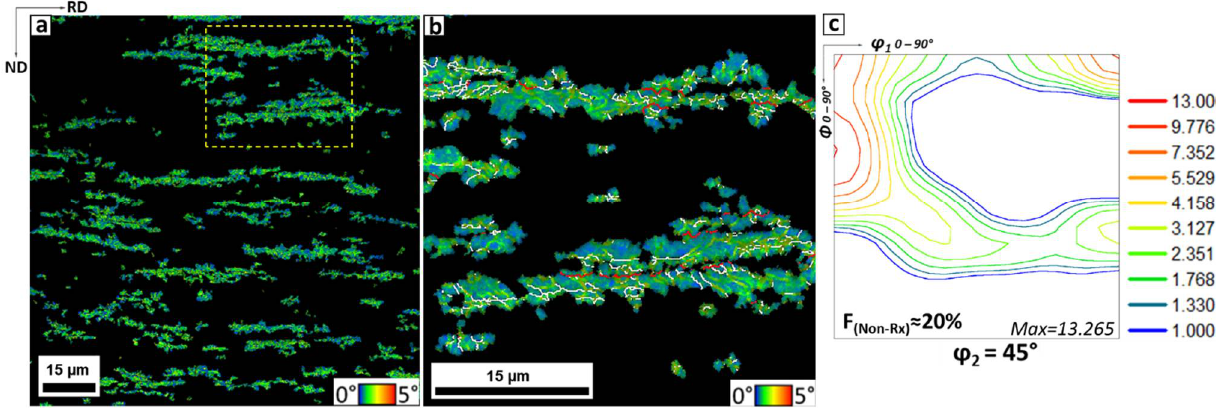
Figure 9. Non-recrystallized ferrite obtained in a sample heated at 500 °C/s to 800 °C followed by direct quenching: ( a ) 1st neighbour kernel average misorientation map. ( b ) Enlarged IQ-KAM map of the area enclosed by the dashed square in ( a ). White and red lines define boundaries with misorientation angles between 5–15° and 15–63°, respectively. ( c ) Orientation distribution function (scanned area 22,500 µm 2 ).